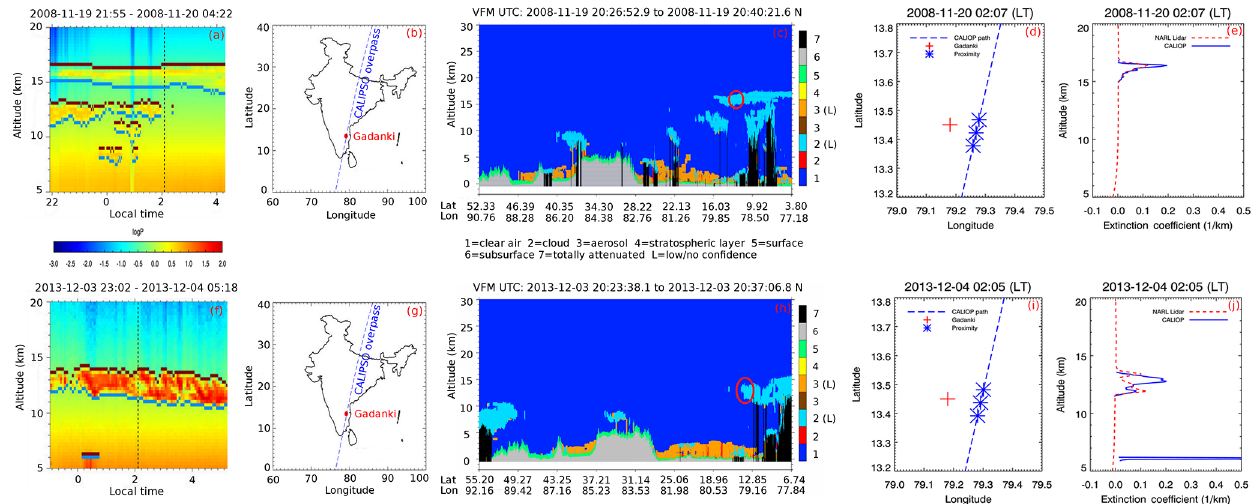
Figure 1. (a) Night-time evolution of cirrus clouds as a function of altitude observed on 19–20 November 2008 using NARL Lidar. Colour scale represents the logarithm of the normalized photon counts. Cirrus base and top altitudes are shown with blue and brown lines, respec- tively. Black dashed vertical line shows the CALIPSO overpass time near Gadanki. (b) Overpass trajectory of CALIPSO (shown by dashed blue line) near Gadanki (shown by filled red circle). (c) Colours show the vertical feature mask (VFM) along the CALIPSO track as a func- tion of altitude on 20 November 2008. The red circle shows the clouds sampled near Gadanki. (d) Overpass trajectory of CALIPSO (dashed blue line) at around 02:07LT on 20 November 2008 near Gadanki (red plus symbol). Blue asterisks correspond to the proximate CALIOP profiles used for averaging, (e) averaged extinction coefficient profiles obtained from NARL Lidar (dashed red line) and CALIOP (solid blue line). (f) to (j) are same as (a) to (e) respectively but for the observations on 3–4 December 2013.